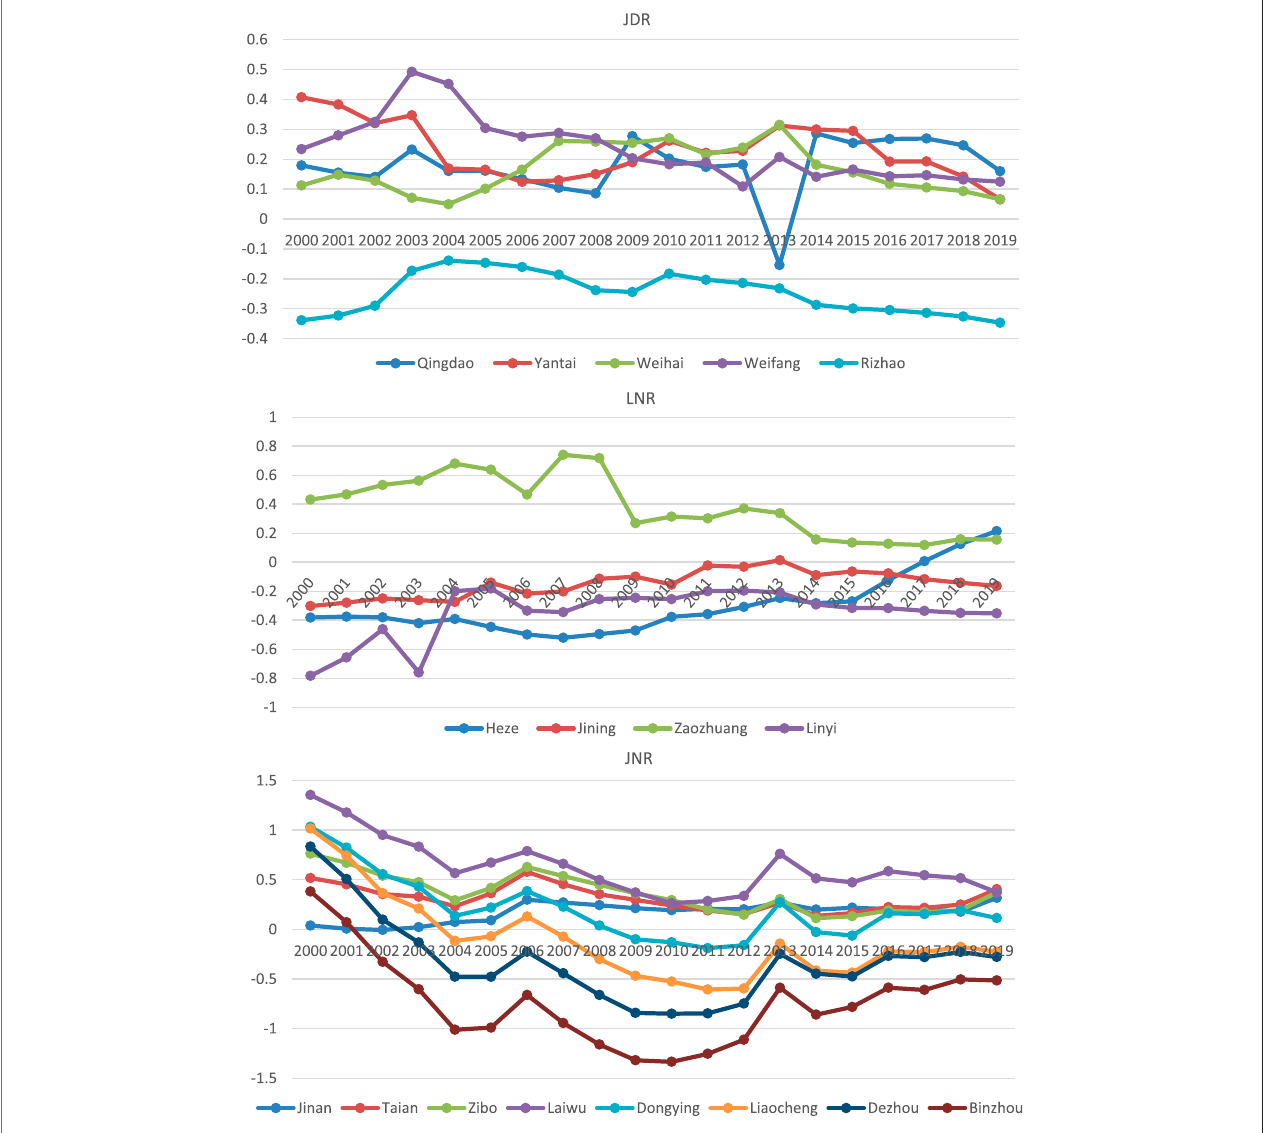
FIGURE 4 | SMCL changes of different regions in Shandong Province between 2000 and